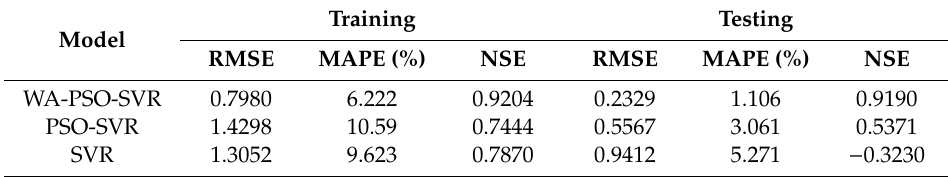
Table 4. Statistical values of daily dissolved oxygen (DO) prediction in the training and testing phase. Training Model